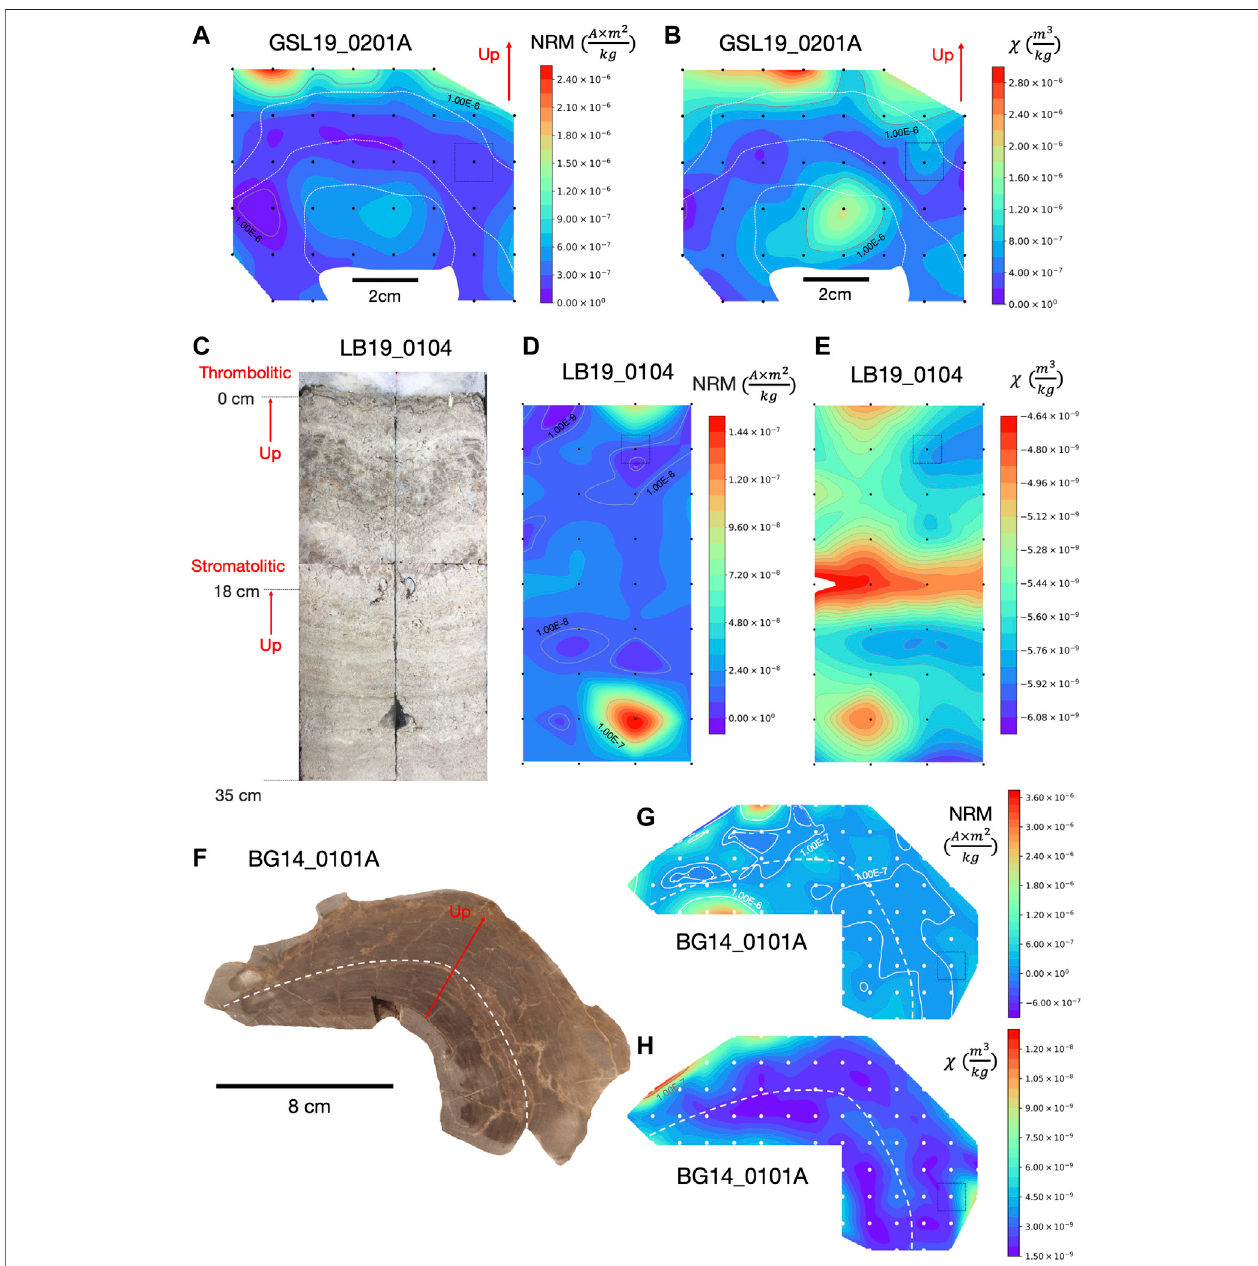
FIGURE2| NRMintensityandmagneticsusceptibilitymapsofmicrobialiteswithcubicinterpolationtoproducecontours. (A) NRMintensitymapand (B) magnetic susceptibility map of GSL19_0201A with approximate 1.5 cm spatial resolution. (C) Photo of split large push core (LB19_0104) from unlithi fi ed living microbialite with stromatolitic structures laminations up to 18 cm and thrombolitic structures from 18 cm to the top. (D) NRM intensity map and (E) magnetic susceptibility map of LB19_0104 with approximate 3.5 cm spatial resolution. (F) Photograph of BG14_0101 sample slice prior to sub-sampling, and (G) its NRM intensity map and (H) magnetic susceptibility map with approximate 1 cm spatial resolution. Color contours are on a linear scale but labeled gray contour lines show order of magnitude variations. Black or white dots are sample positions and the color bars represent NRM intensity (Am 2 /kg) and magnetic susceptibility (m 3 /kg) values in the color range. Gray squares illustrate approximate specimen sizes on sample maps. Solid (up) red arrow indicates up in the fi eld and is similar to the sample growth direction. White dashed lines roughly represent locations of distinct laminations. The red arrow represents the up direction in the fi eld, which is close to the growth direction.